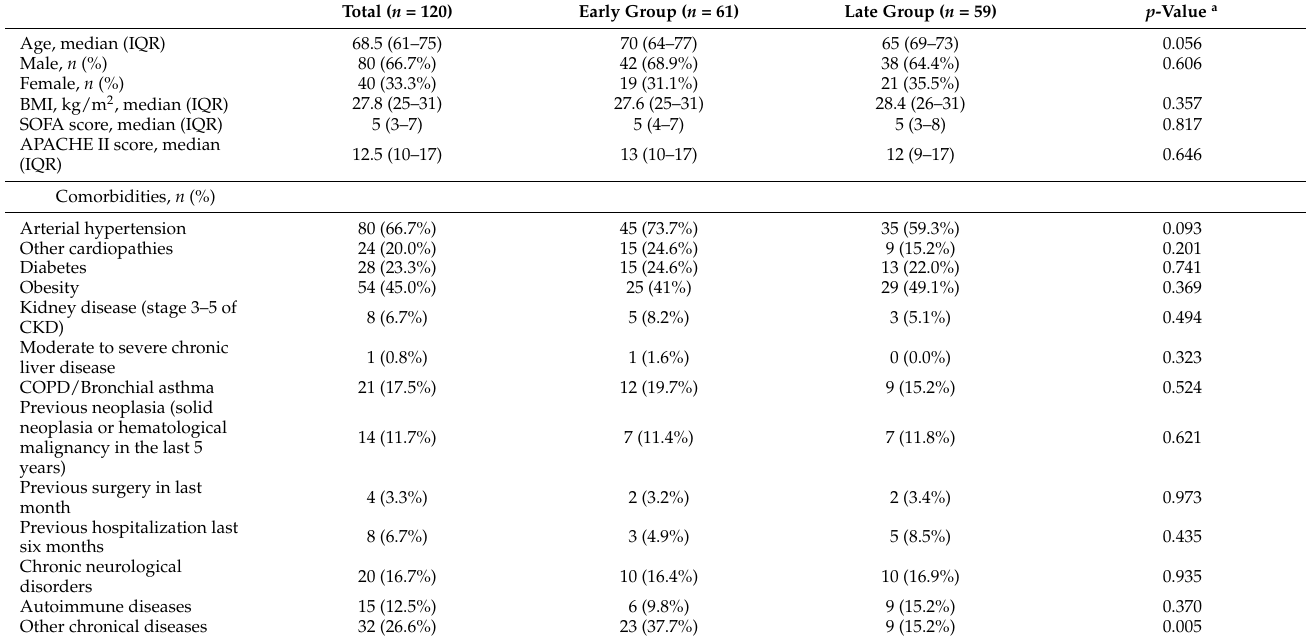
Table 1. The baseline characteristics of ICU COVID-19 patients who underwent